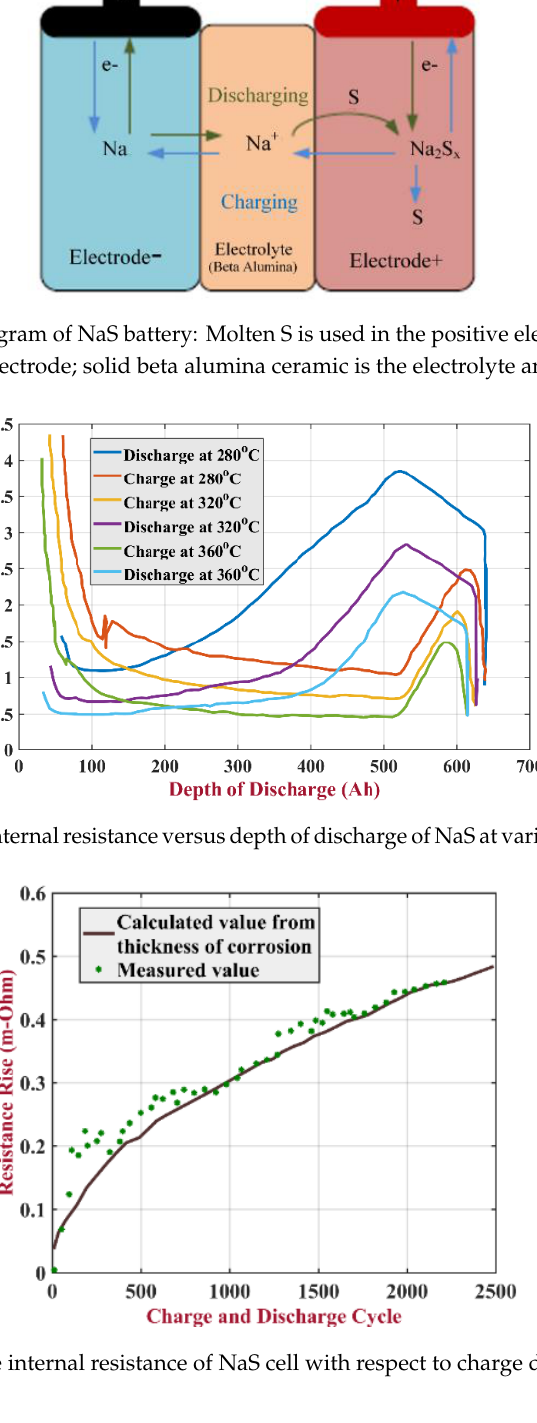
Figure 33. Graph of the internal resistance of NaS cell with respect to charge discharge cycle [109].